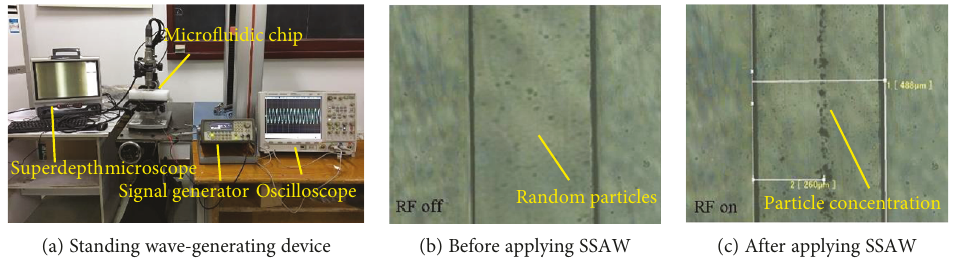
Figure 4: Particle concentration experiment device and result graph